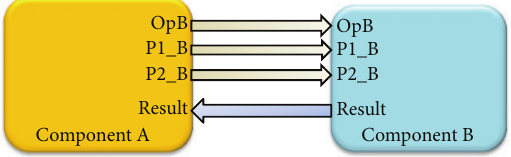
Figure 1: Point to point object